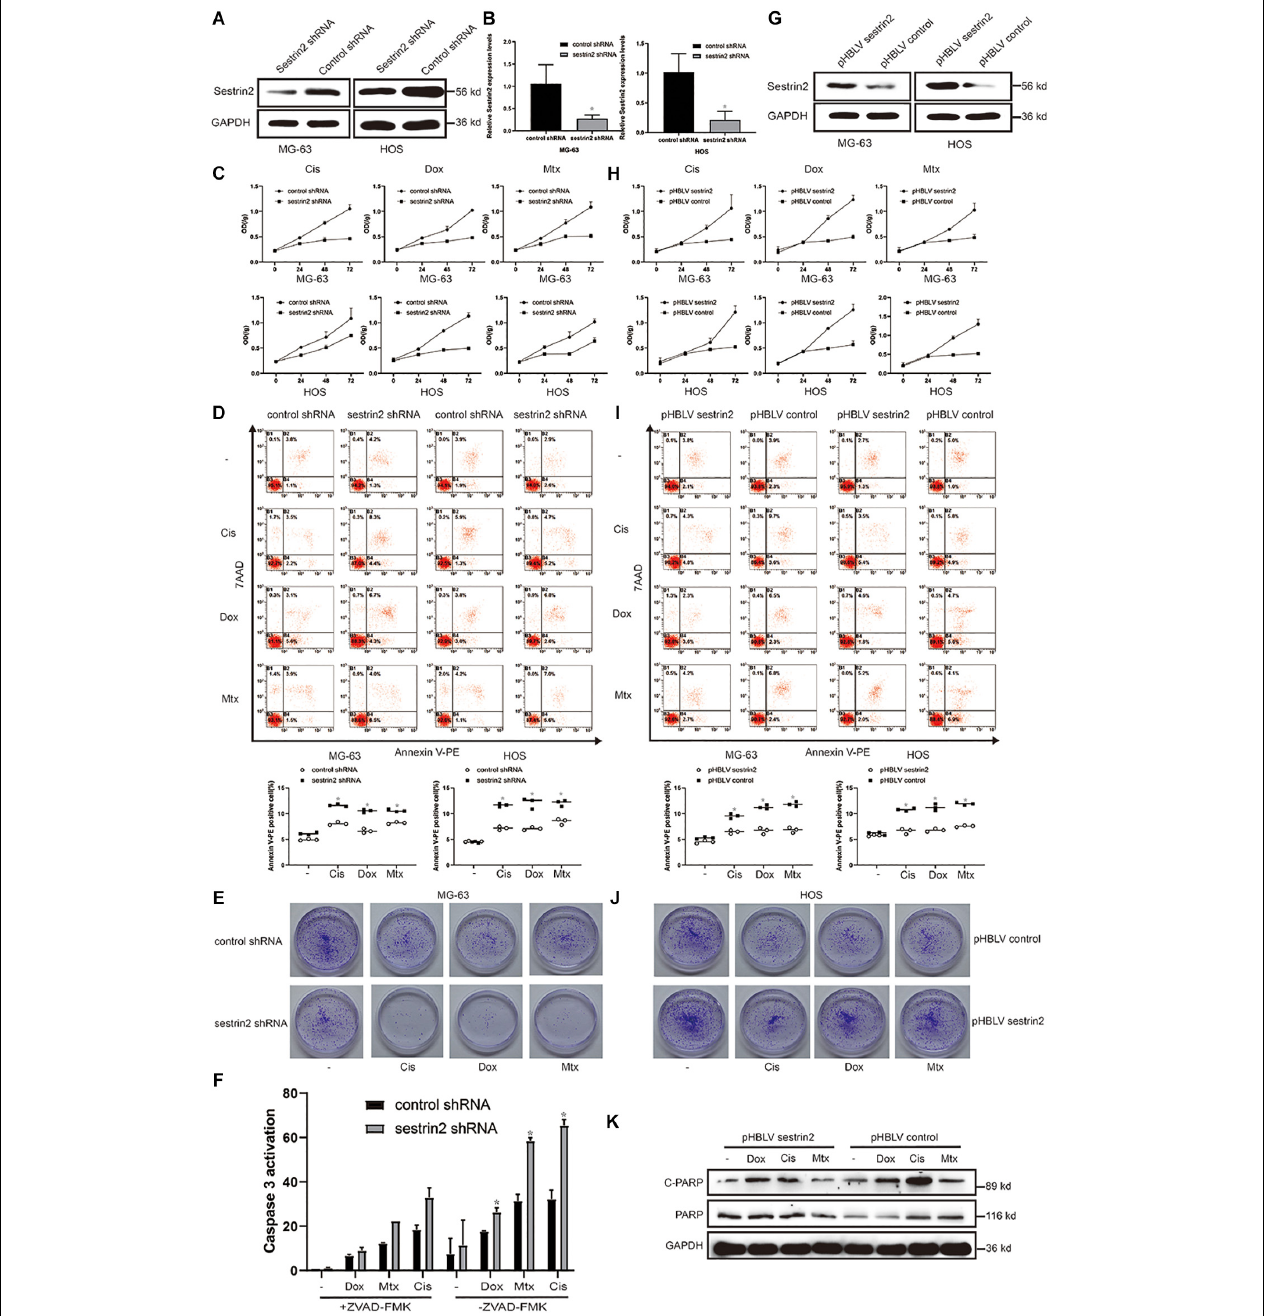
FIGURE 2 | SESN2 confers drug resistance to target cells by reducing their sensitivity to chemotherapeutic agents. MG-63 and HOS cells were transfected with control shRNA or SESN2 shRNA, and the knockdown effect was detected by western blot ( n = 3) and quantitative real-time PCR ( n = 3) (A,B) . MG-63 and HOS cells with SESN2 knockdown were treated with Cis (20 µ mol/L), Dox (0.2 µ g/mL), or Mtx (50 µ mol/L) for 24, 48, and 72 h. Cell activity was detected by CCK-8 (C) ( n = 3). After treatment for 24 h, apoptotic cells were detected by flow cytometry (D) ( n = 3). SESN2 knockdown significantly reduced the number of colony-forming MG-63 cells (E) ( n = 3). After MG-63 cells were treated with Cis (20 µ mol/L), Dox (0.2 µ g/mL) or Mtx (50 µ mol/L) for 24 h, the apoptosis of cells transfected with control shRNA or SESN2 shRNA and cultured in the presence or absence of ZVAD-FMK (20 µ mol/L) was detected using the Caspase 3 kit (F) ( n = 3). The data are presented as the mean ± SD. * p < 0.05 vs. the Control shRNA group. The expression of SESN2 after transfection of a plasmid carrying the SESN2 gene was evaluated by western blot (G) ( n = 3). MG-63 and HOS cells overexpressing SESN2 as well as their corredsponding control cells were treated with Cis (20 µ mol/L), Dox (0.2 µ g/mL), or Mtx (50 µ mol/L). Cell viability and apoptosis were detected by CCK-8 (H) ( n = 3) and flow cytometry (I) ( n = 3), respectively. SESN2 increases the number of colony-forming units of HOS cells (J) ( n = 3). Cleaved and total PARP in SESN2-overexpressing and control HOS cells were analysed by western blot (K) ( n = 3). The data are presented as the mean ± SD. * p < 0.05 vs. the pHBLV control group.